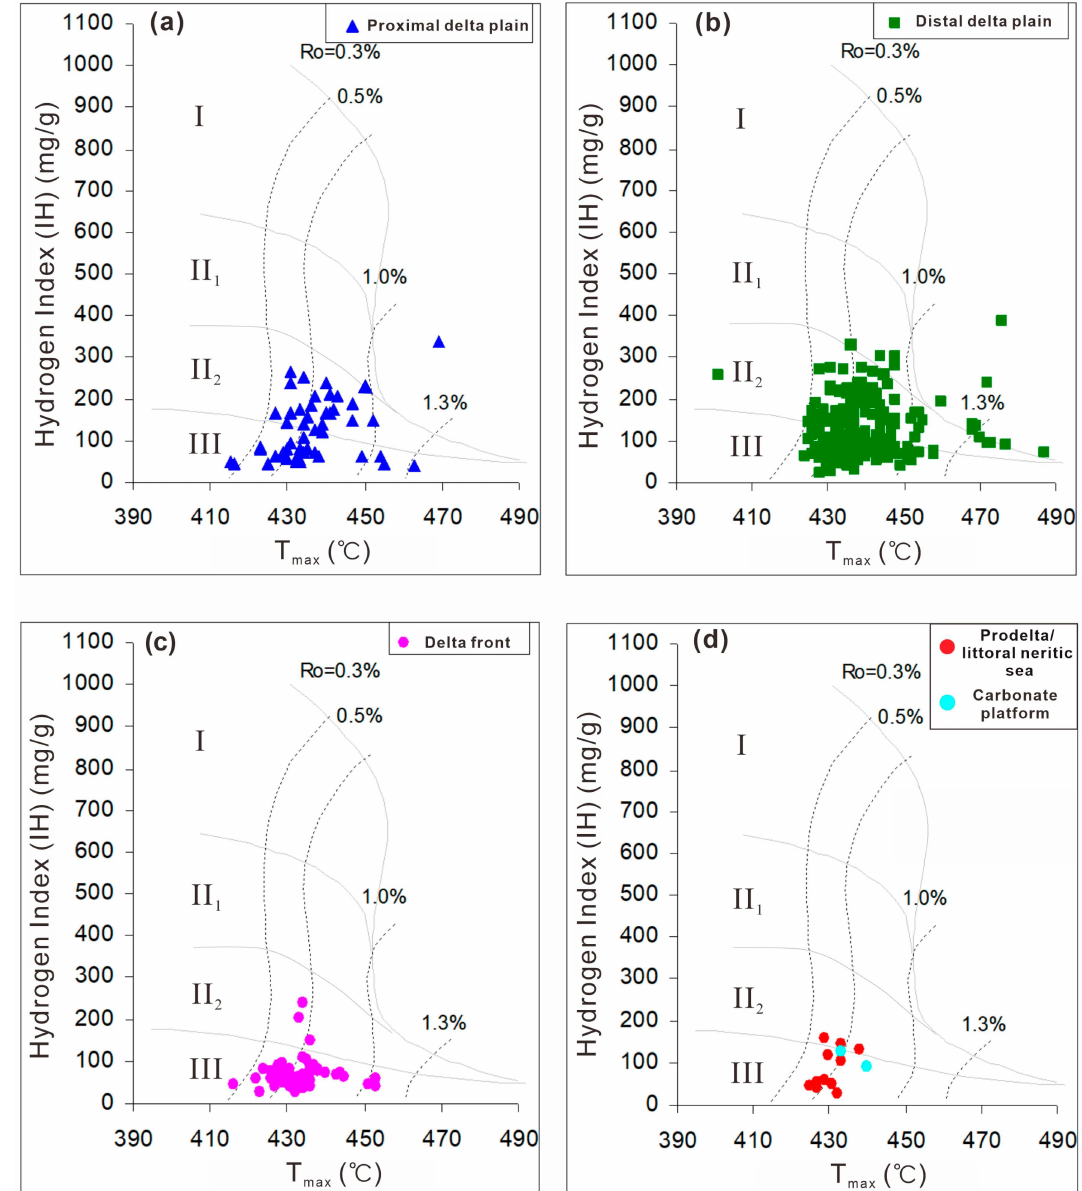
Figure 10. Organic matter types, maximum pyrolysis peak temperature (T max ), and hydrogen index (IH) characteristics of the Mungaroo Formation source rocks in different sedimentary facies or subfacies, including the ( a ) proximal delta plain, ( b ) distal delta plain, ( c ) delta front and ( d ) prodelta, littoral neritic sea, and carbonate